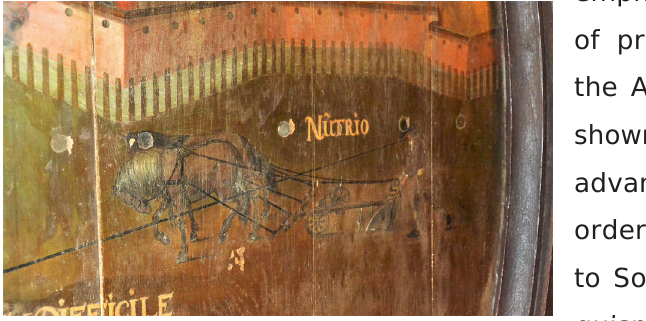
Figure 13 The peasant: “Nutricio”.